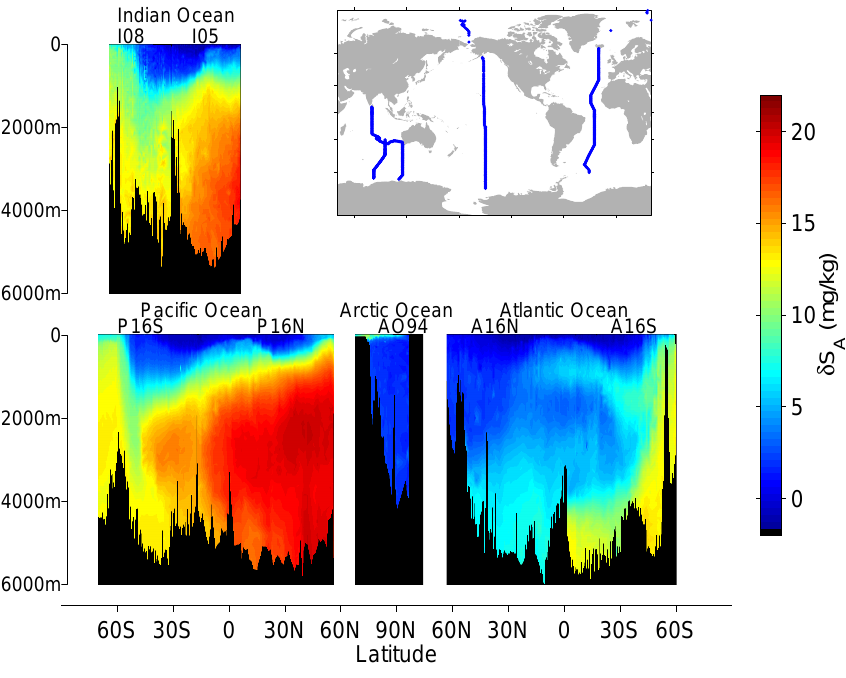
Fig. 1. Salinity anomalies δS A for trans-oceanic hydrographic sections in different oceanic basins. Values are calculated by the numerical model of Pawlowicz et al., (2011) using archived observations of carbon parameters and nutrients along these sections. Data obtained from the CLIVAR and Carbon Hydrographic Data Office